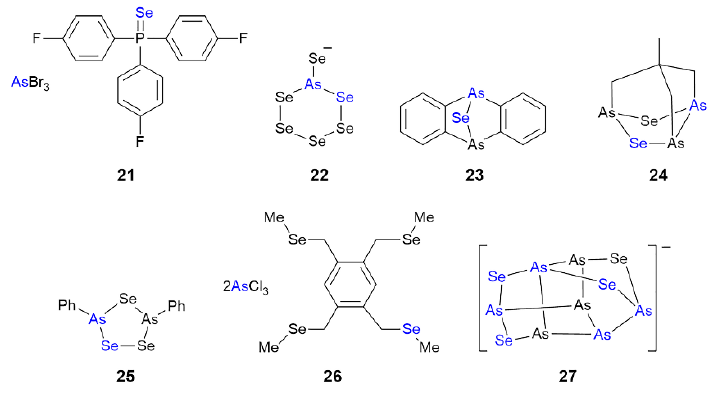
Figure 6. Chemical diagrams for arsenic compounds 21 – 27 .